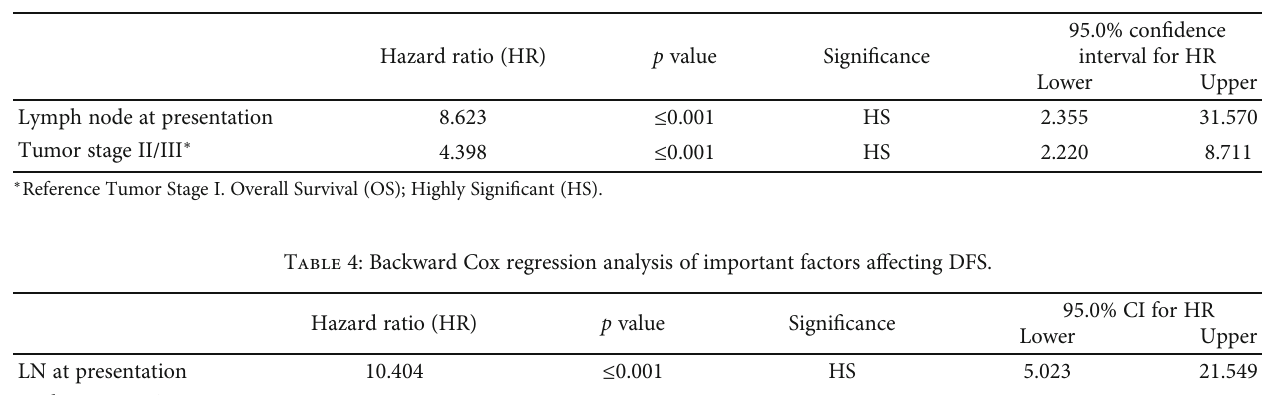
Figure 4: Kaplan Meier analysis of SLC34A2 IHC expression: correlation with OS is not signi fi cant ( p = 0 : 111 ) (a) and high SLC34A2 correlates with shorter DFS ( p = 0 : 005 ) (b). Table 3: Backward Cox regression analysis of important factors a ff ecting OS.